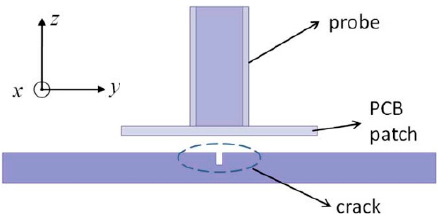
Figure 21. Diagram of the method for detecting long cracks on a metal surface (from [40]; copyright © IEEE 2014; reproduced with permission).